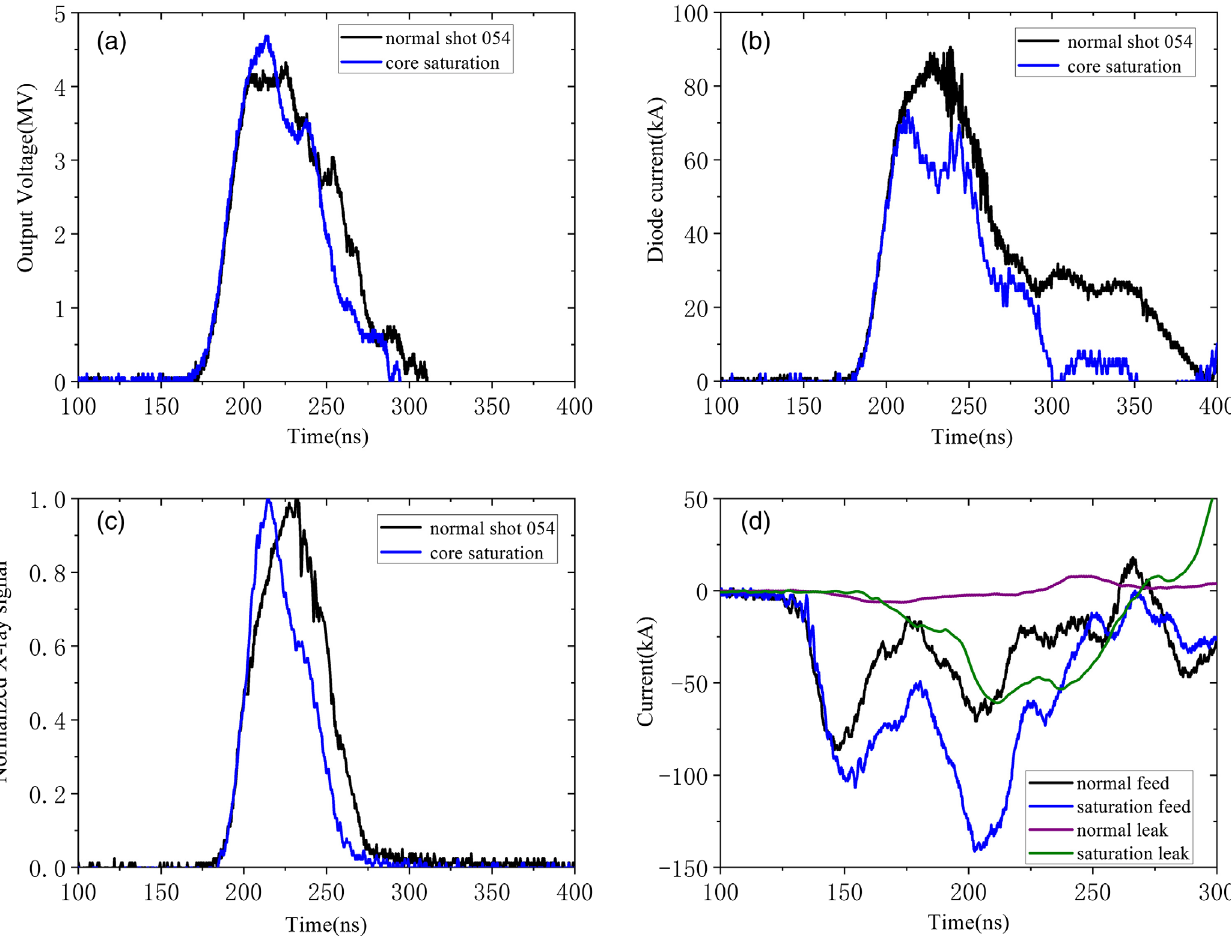
FIG. 11. Comparison of electrical measurements from the core-saturation shot 015 (blue traces) and the normal shot 054 (black traces). (a) Output voltage, (b) diode current, (c) normalized x-ray signals, and (d) feed and leakage currents from the second cavity. The latter indicates that the cores are saturated.